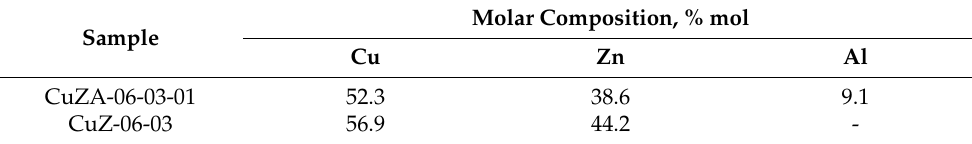
Table 3. Amount of Cu, Zn, and Al by ICP in the investigated